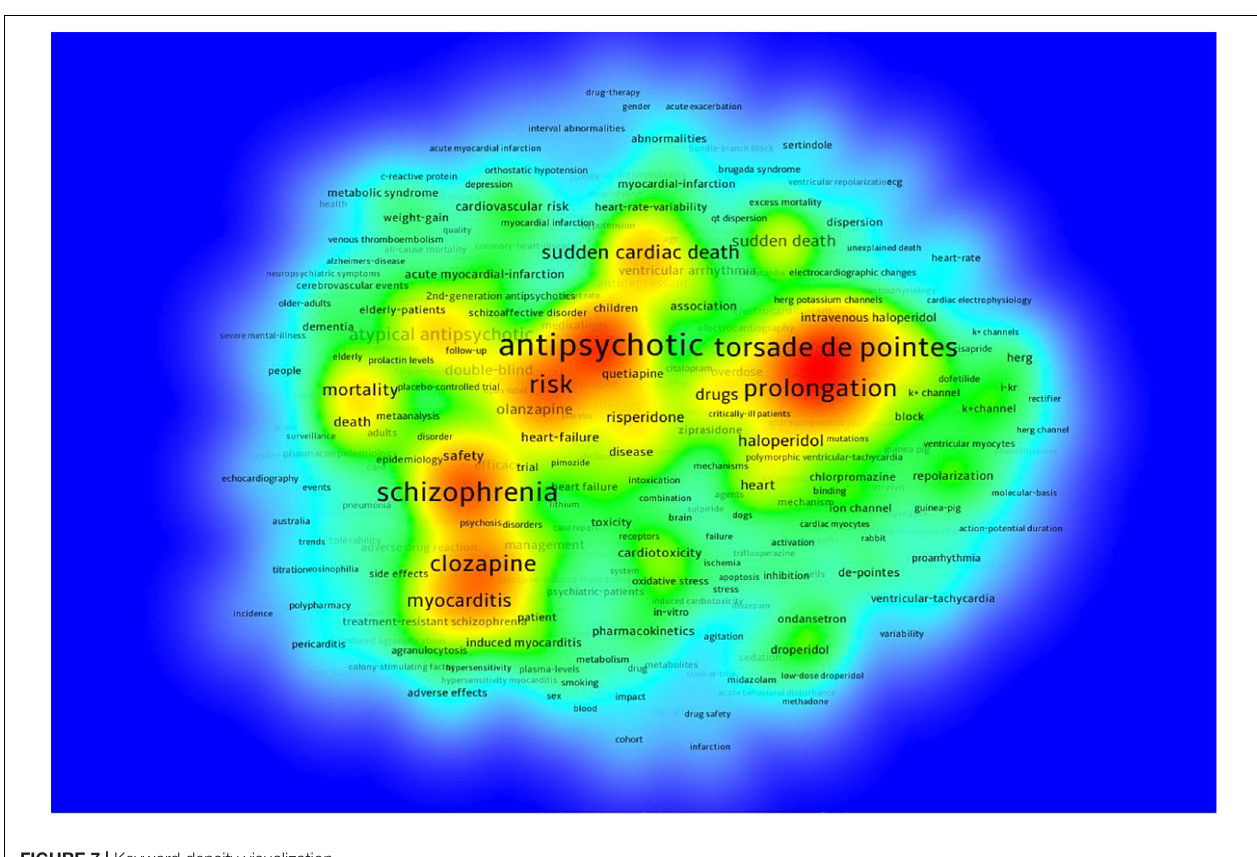
FIGURE 7 | Keyword density